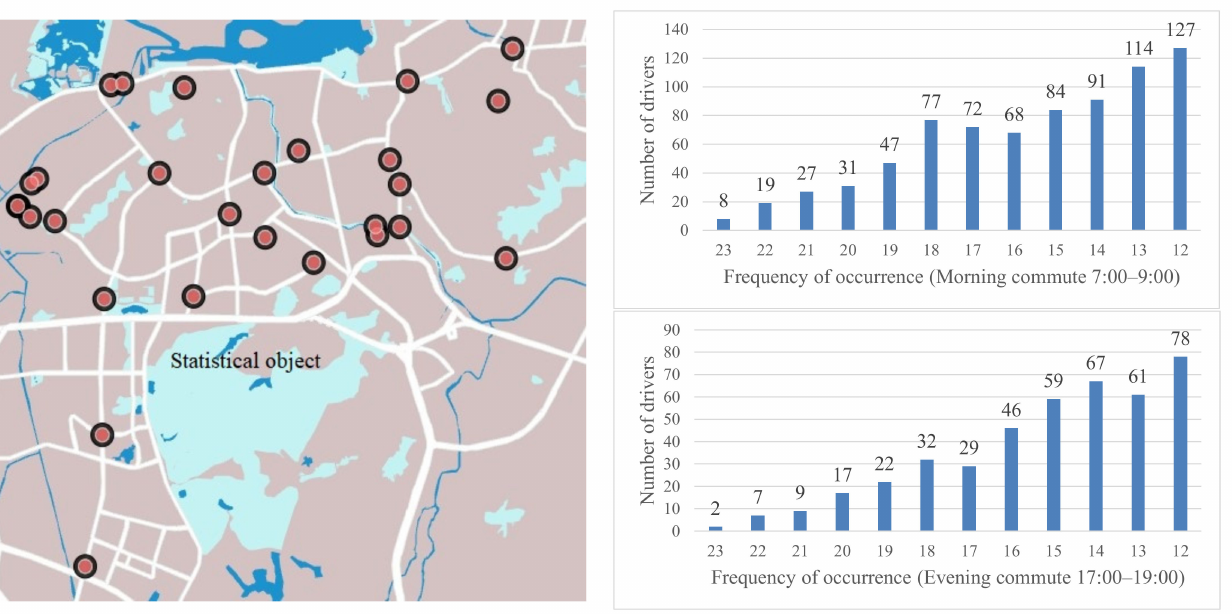
Figure 1. Evidence of habit from the statistical results of the plate recognition date. (The left figure shows the distribution of 27 road securities (see the red circles). The right figure shows the statistical results of the frequency of the same car that showed up at the same road security from 20 March 2018 to 16 April 2018, for 23 workdays. There are about 33,488 observation dates in the morning and 33,258 observation dates in the